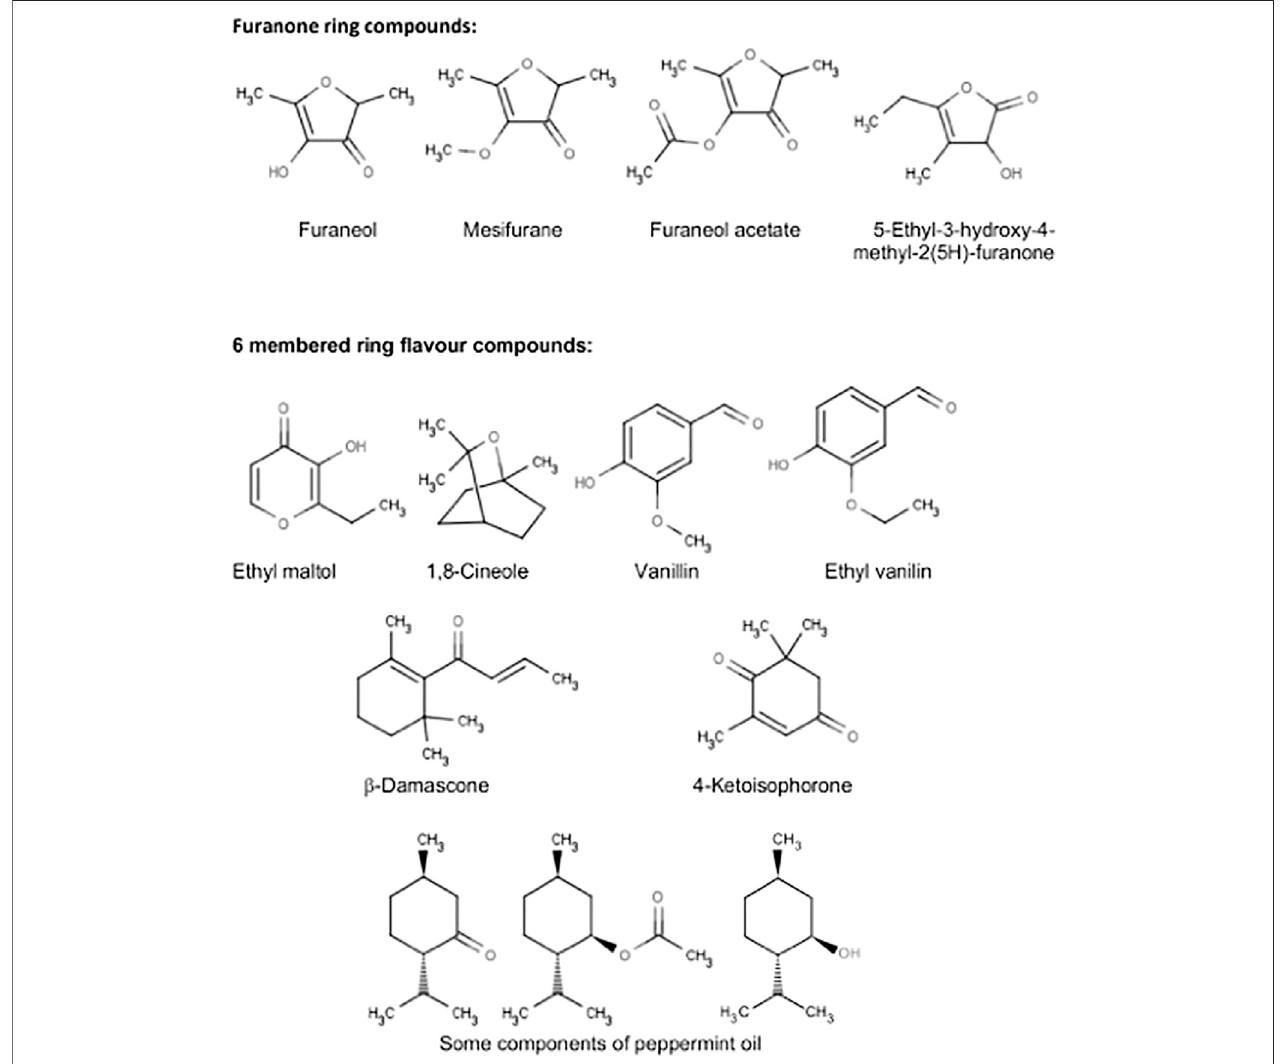
FIGURE 4 | Flavour compounds examined in the pyrolysis screening